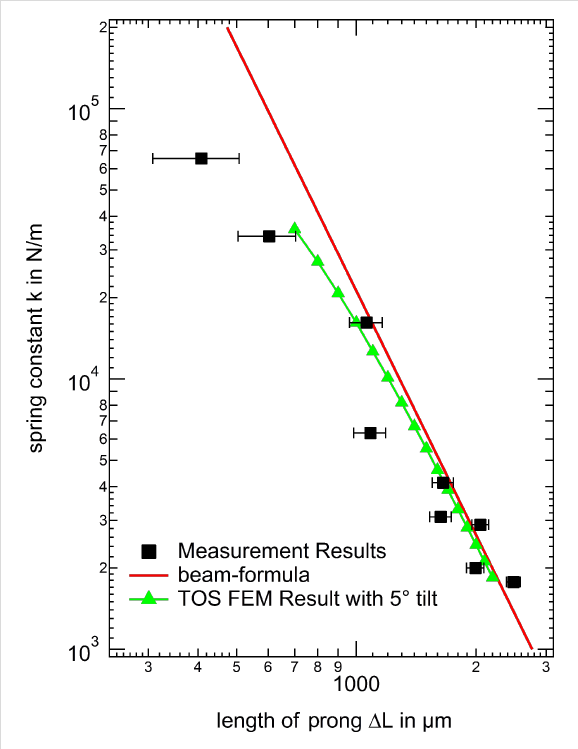
Figure 10: Comparison of the spring constants from experiment with FEM simulations and calculations using the beam formula (with the new origin L 0 = − 250 μ m for both). The experimental values still shows a deviation from the simulations and calculation respectively. This is possibly caused by some tilt of the sensor towards the force applica- tion axis where small angles cannot be completely avoided in the fabri- cation